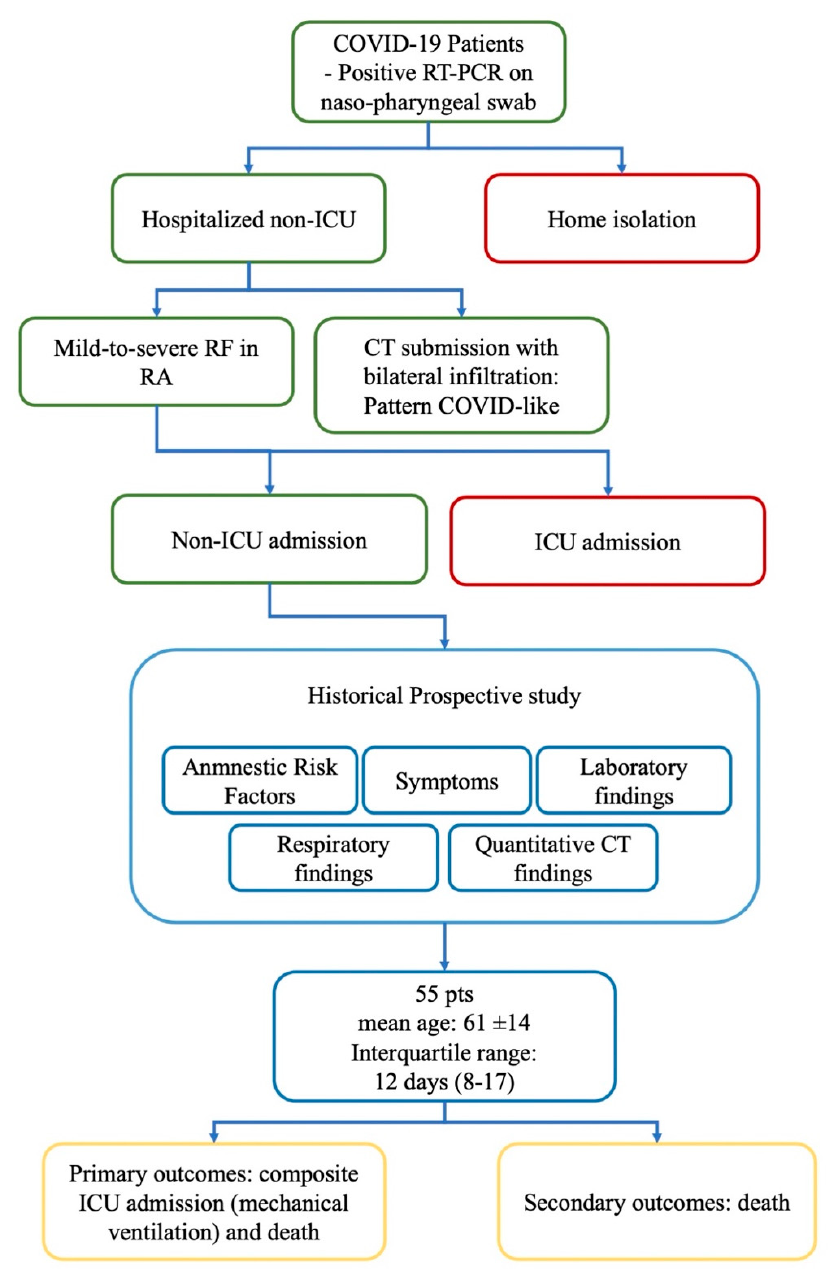
Figure 2. Flowchart of the study. Green rectangles show inclusion criteria; in red, exclusion criteria. Analyzed parameters are within blue rectangles. In yellow, outcomes. RT-PCR: reverse transcriptase polymerase chain reaction; ICU: intensive care unit; RF: respiratory failure; RA: room air; CT: computed tomography; pts: patients.